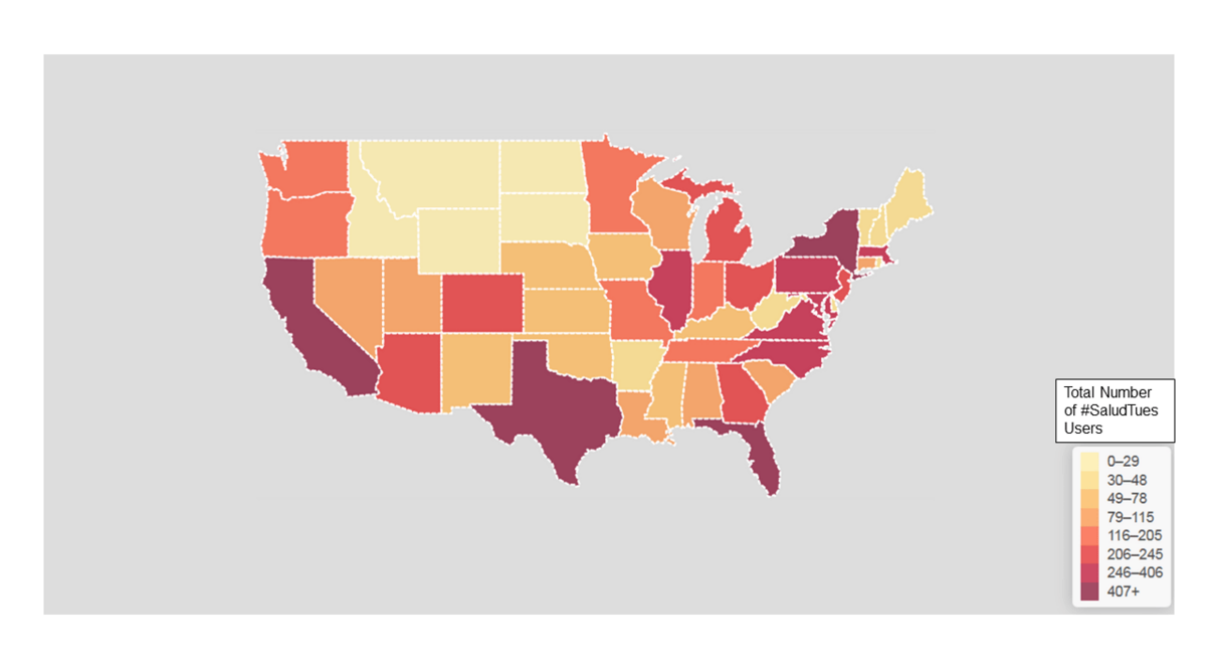
Figure 2. Choropleth map of the United States showing where Tweetchat users are tweeting from, between November 1, 2014, and August 31, 2018.